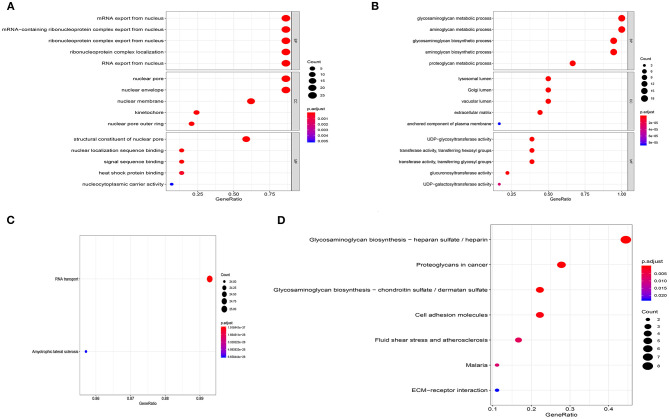
Enrichment analysis of the first two modules. (A) GO analysis of module 1. (B) GO analysis of module 2. (C) KEGG analysis of module 1. (D) KEGG analysis of module 2.